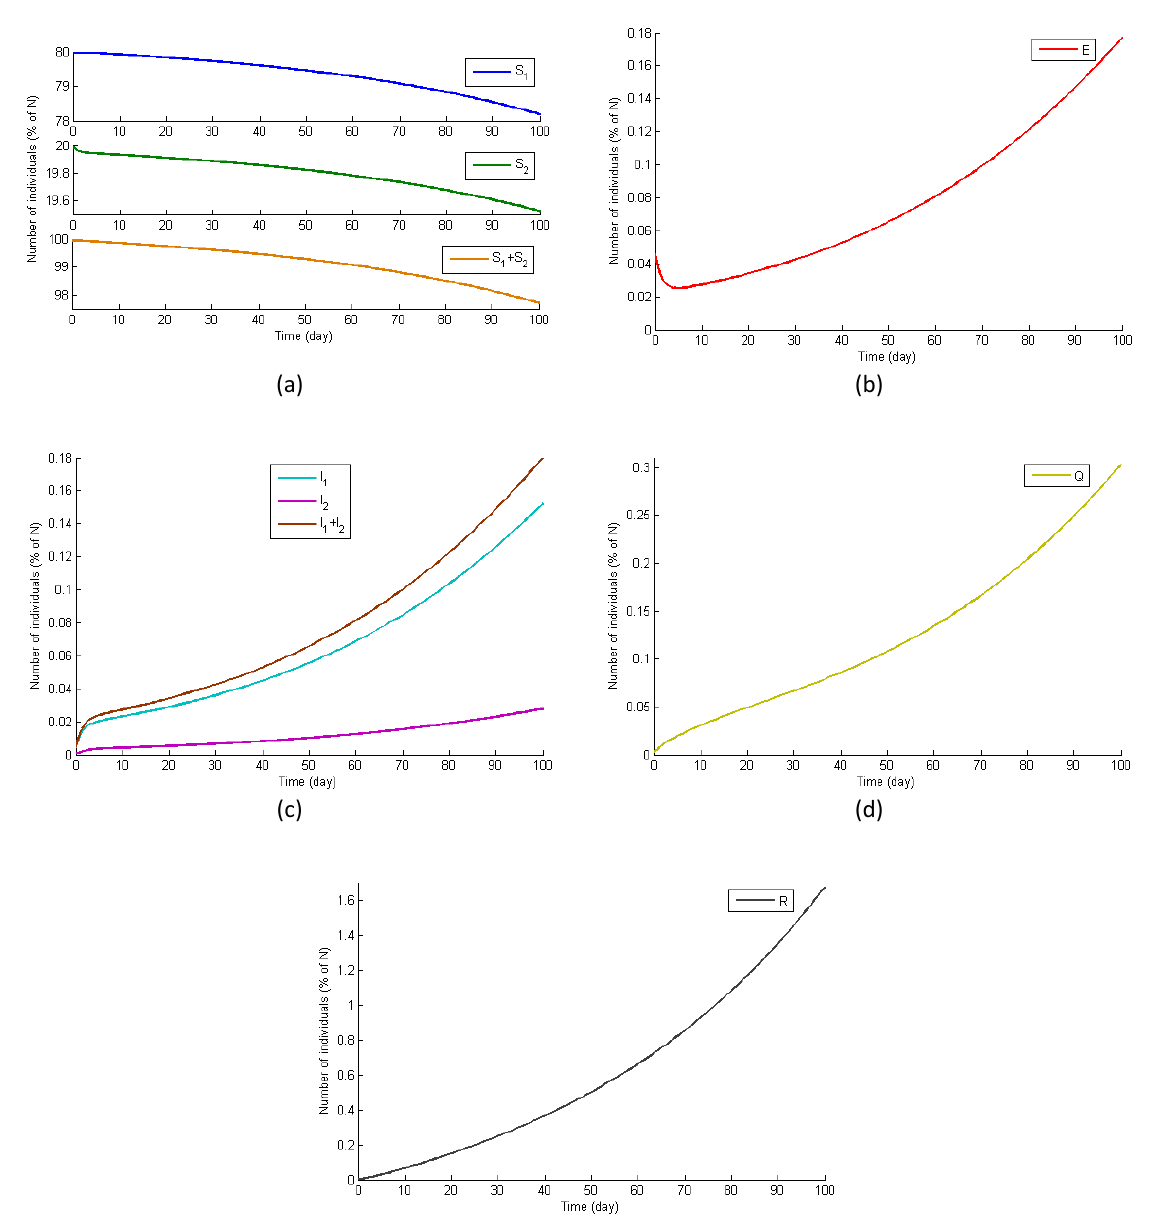
Fig. 2 : The subpopulation of the spread of COVID-19 with